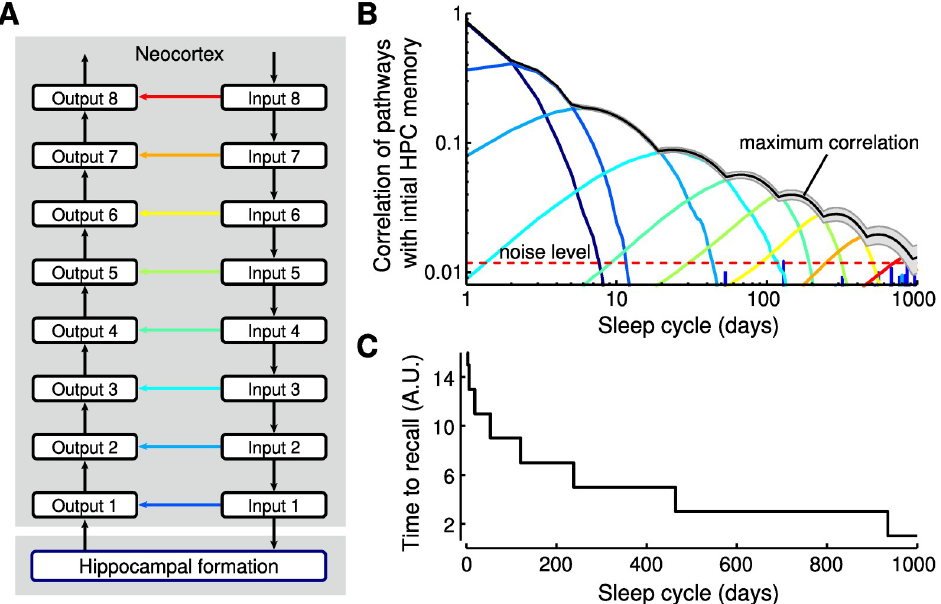
Fig 5. Consolidation from hippocampus into neocortex by hierarchical nesting of consolidation circuits. (A) Schematic of the hierarchical model. The hippocampal formation (HPC) is connected to cortical input circuit 1 and output circuit 1. Increasing numbers indicate circuits further from the HPC and closer to the sensory/motor periphery. Each direct connection at one level (e.g., dark blue arrow between input 1 and output 1) is part of the indirect pathway of the next level (e.g., for pathways from input 2 to output 2). Learning rates of the direct connections decrease exponentially with increasing level (i.e., from blue to red). (B) Memories gradually propagate to circuits more distant from the HPC. The correlation of the initial HPC weights with the direct pathways is shown as a function of time and reveals a memory wave from HPC into neocortex. The maximum of the output circuits follows approximately a power-law (black curve). Noise level indicates chance-level correlations between pathways. (C) Consolidated memories yield faster responses (from sensory periphery, e.g., Input 8, to system output) because these memories are stored in increasingly shorter synaptic